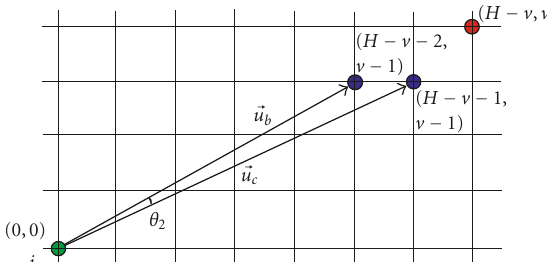
Figure 4: In order for the node ( H − v , v ) to be vwi to the source at the origin, the corresponding beam has to “clear” nodes ( H − v − 2, v − 1) and ( H − v − 1, v − 1). In this figure, H = 11 and v = 4 so that v > H/ 3.